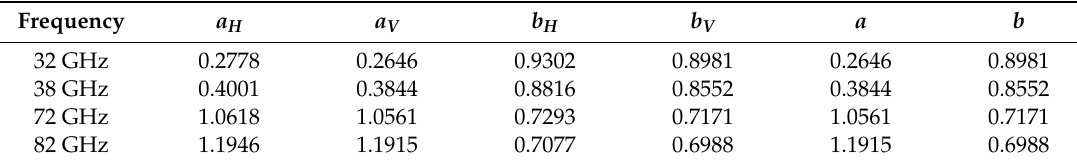
Table 1. Assuming vertical polarization, the power law coe ffi cients a and b used in our measurement are given in Table 1. Table 1. Power law coe ffi cients for di ff erent